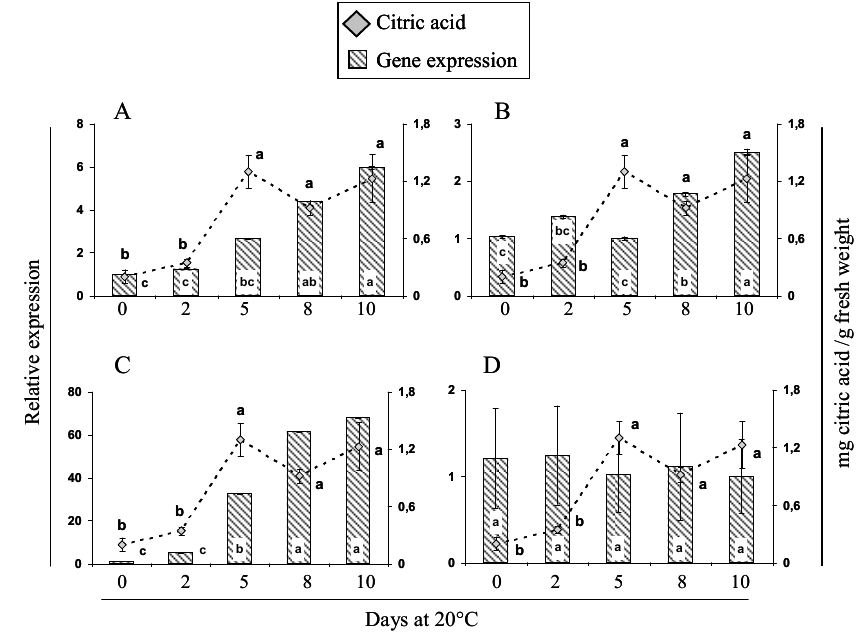
Figure 4. Expression profiles of putative genes related to the synthesis or degradation of citric acid during ripening of cherimoya cv. “Concha Lisa”. The following genes were analyzed by qPCR: ( A ) citrate synthase, Ac-mCS ; ( B ) aconitate hydratase 1, AcACON ; ( C ) ATP citrate synthase, AcATP-CS ; and ( D ) NADP-dependent isocitrate dehydrogenase, AcNADP-IDH . Expression was normalized to the reference gene AcUbiq (GenBank FJ664263) and the value is expressed against the lowest value of relative abundance. In each panel, gene expression (bars) was compared with the concentration of citric acid (gray rhombus). Different letters between each time point represent significant differences at p ≤ 0.05 by the LSD test.